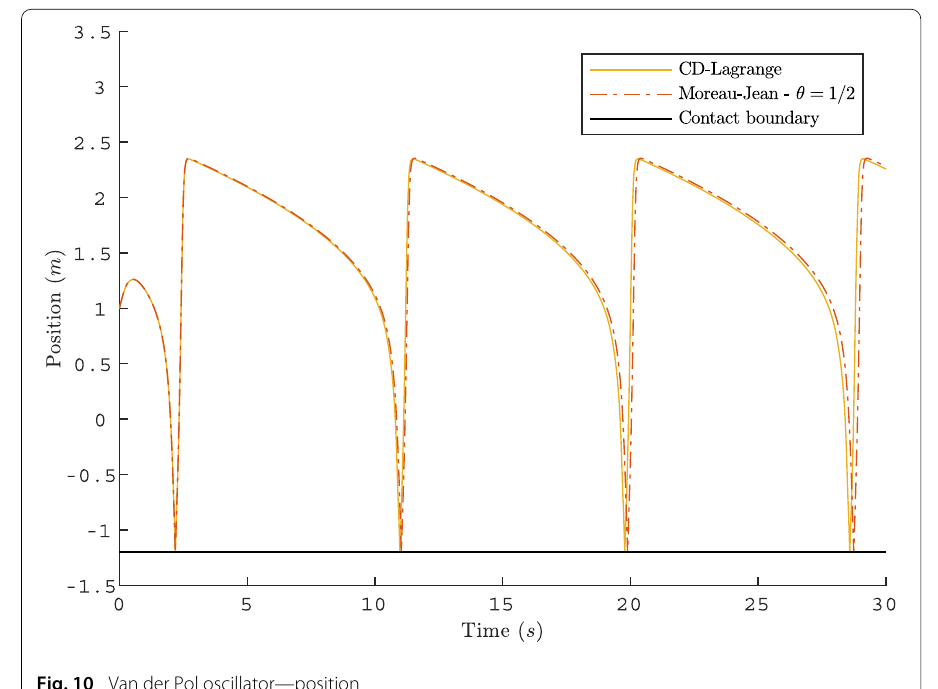
Fig. 10 Van der Pol oscillator—position